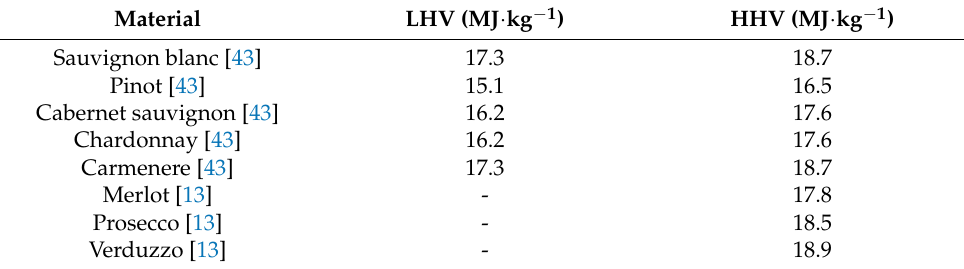
Table 4. Comparison of LHV and HHV of vineyard pruning